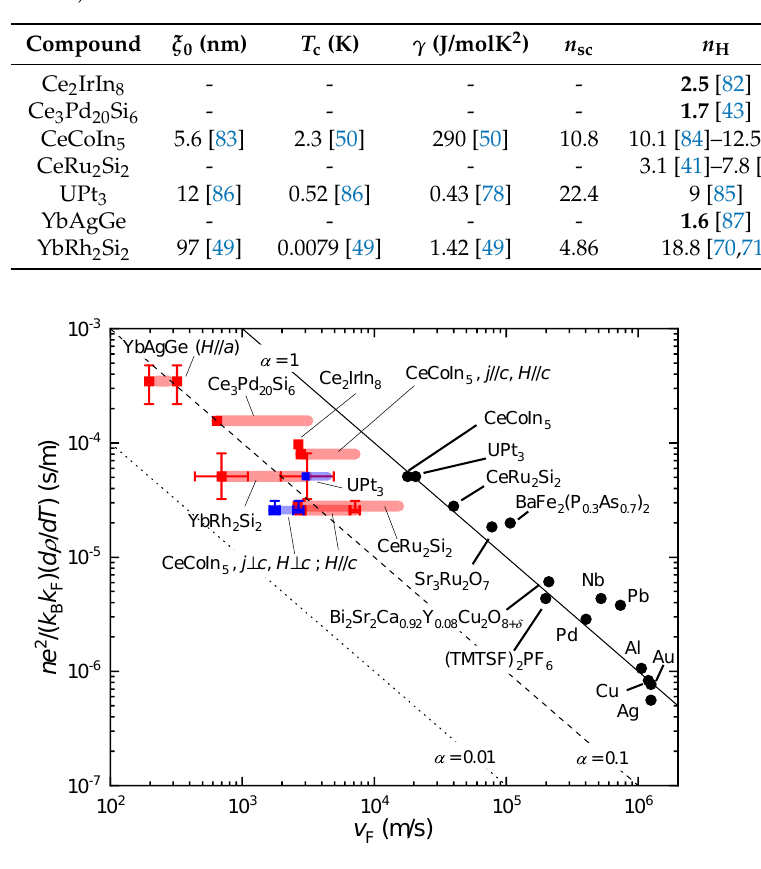
Figure 3. Planckian dissipation plot of [10] revisited. Double-logarithmic plot of Fermi velocity v F vs. ne 2 / ( k B k F )( d ρ / dT ) = α / v F with data from [10] (black points) and data of the heavy fermion compounds listed in Table 1 and analyzed here. The red squares result from the largest measured A coefficient (or γ value) for each compound near the strange metal regime, the shaded red lines from the published ranges of A coefficient (or γ value), and the error bars from uncertainties in the determination of the charge carrier concentration n and sometimes other parameters (see Table 1). The full, dashed, and dotted line represent α = 1, 0.1, and 0.01,